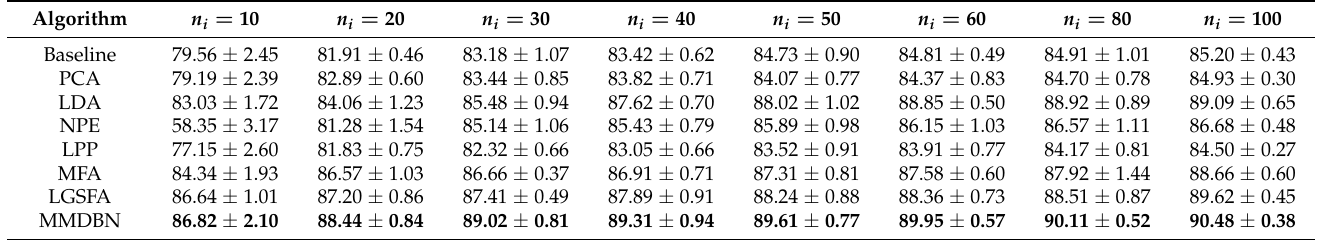
Table 2. The classification results of different DR algorithms for Salinas dataset (overall accuracy ± Std (%)).